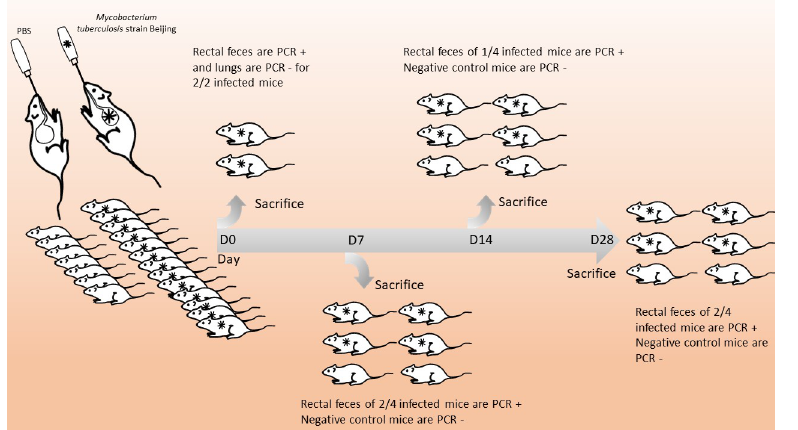
Fig 1. Infection of the digestive tract in a mouse model of ingested M . tuberculosis